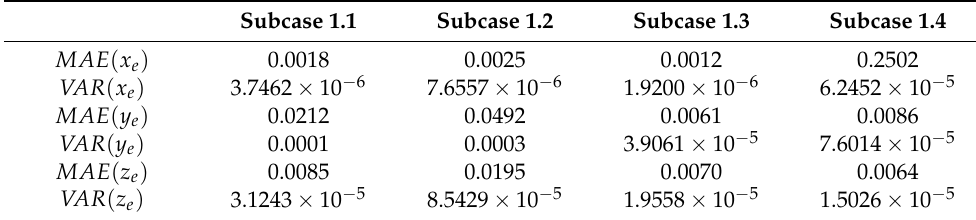
Table 6. Data analysis of steady-state for Case 1 (from 40 s to 150 s).